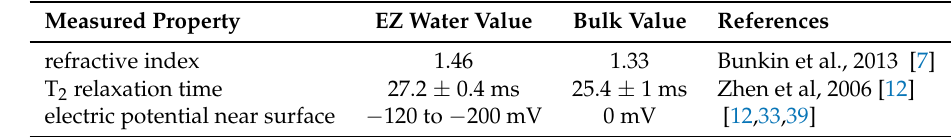
Table 1. Some of the reported properties of the exclusion zone